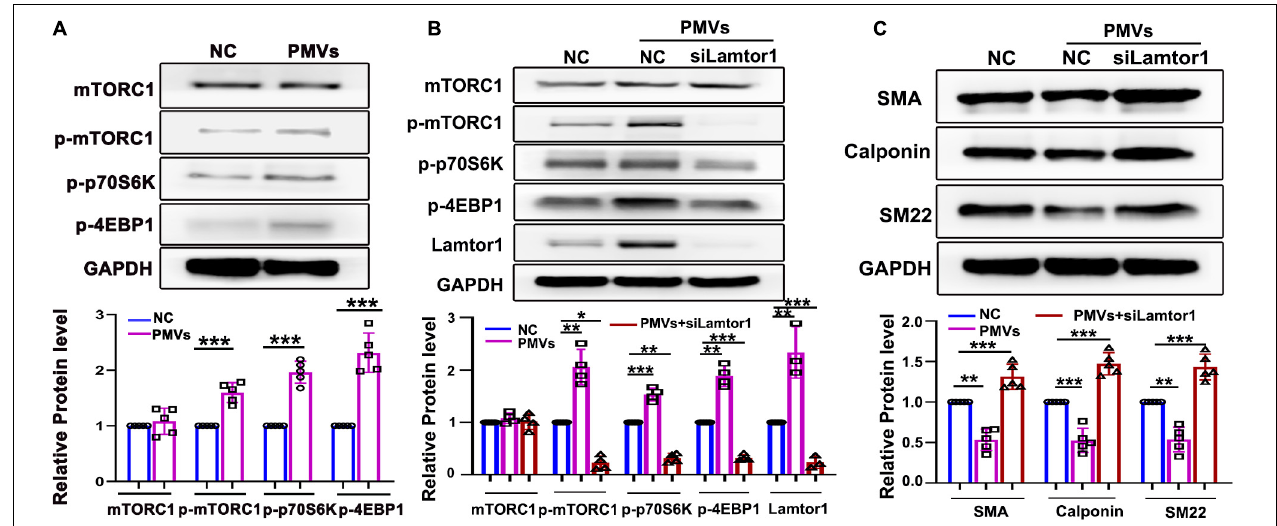
FIGURE 2 | Specific knockdown of Lamtor1 reversed the effects of PMVs on mTORC1 activation and VSMC dedifferentiation. (A) Western blot showed that the phosphorylations of mTORC1, 4EBP1 and p70S6K in VSMCs were increased by PMVs, while the total mTORC1 level did not change ( n = 5). Data represent mean ± SD. *** P < 0.001. (B) Specific siRNA transfection significantly reversed the effects of PMVs on expression of Lamitor1 and phosphorylations of mTORC1, 4EBP1 and p70S6K ( n = 4). Data represent mean ± SD. * P < 0.05, ** P < 0.01, *** P < 0.001. (C) Specific Lamtor1 siRNA increased the expressions of VSMC differentiation markers, including SMA, calponin and SM22 under PMV stimulation ( n = 5). Data represent mean ± SD. ** P < 0.01, *** P <